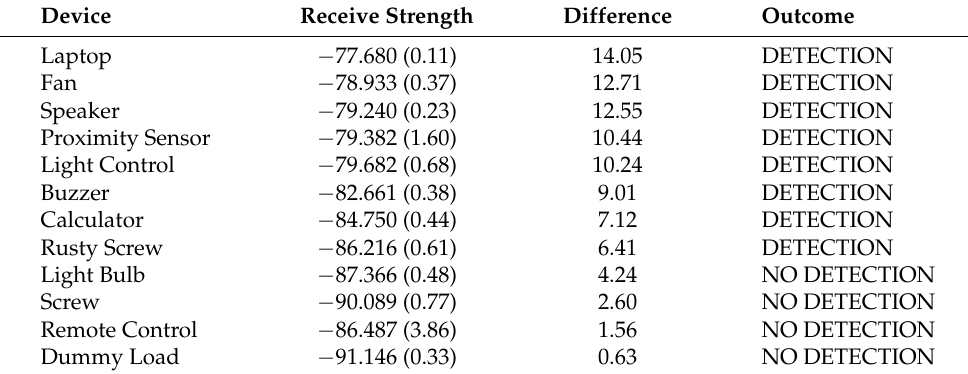
Figure 9. Wired testbed: strength of the received harmonic signal for different targets. The horizontal line shows the threshold set at 5 dB. Targets with returned signal strength of over 5 dB were considered nonlinear (electronic). Table 1. Wired testbed results. The average noise level (floor) was − 91.567 dBm with a standard deviation of 1.466 dB. Each measurement is an average of 15 readings with standard deviation shown in